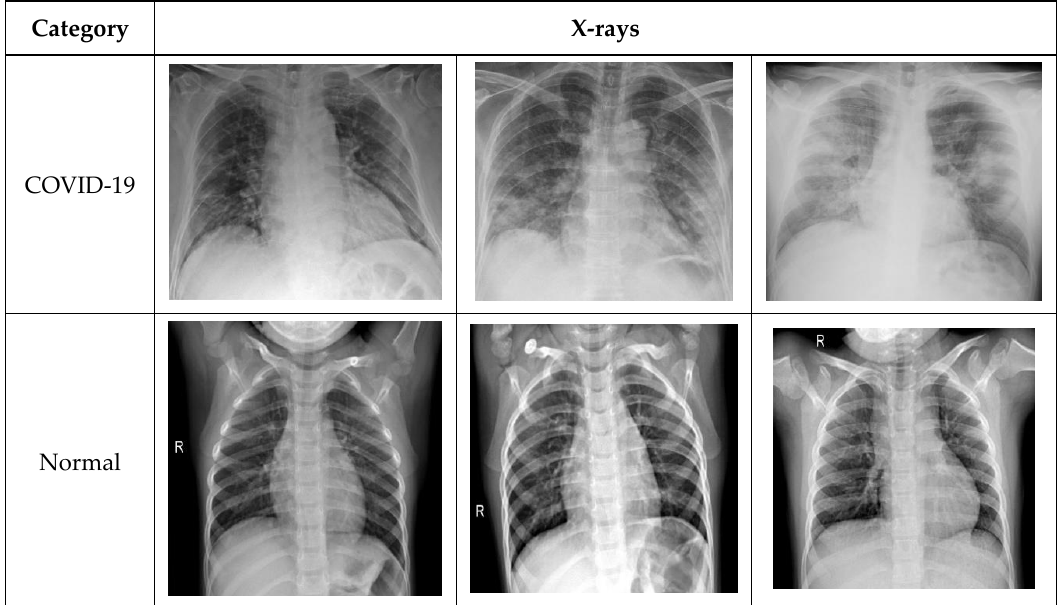
Figure 1. Number of X-ray images per category in the data set.